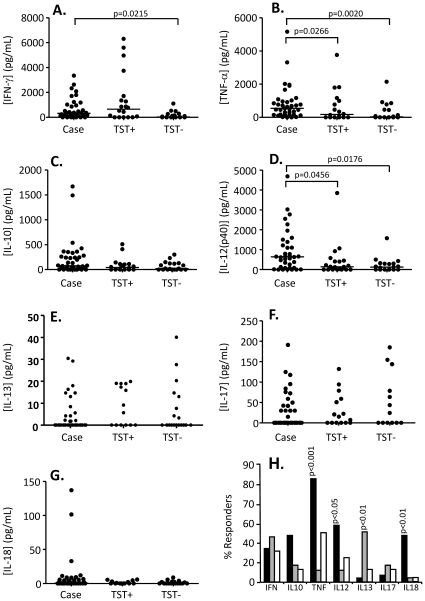
Cytokine responses following TB10.4 stimulation.Whole blood from TB cases (n = 36), TST+ (n = 20) and TST− (n = 19) contacts was stimulated for 7 days with TB10.4 and the supernatant assessed by luminex technology for secretion of cytokines. A) IFN-γ. B) TNF-α, C) IL-10, D) IL-12(p40), E) IL-13, F) IL-17 and G) IL-18. Line indicates median. Data were analysed using Tweedie distributions with p-values indicating significant differences after adjustment for age and sex. H) Percentage of responders (prior to adjustment for age and sex) producing IFN-γ, IL-10, TNF-α, IL-12, IL-13, IL-17, IL-18. Dark bars = cases, grey bars = TST+ contacts, white bars = TST− contacts; p-values are indicated and refer to comparison with TST− contacts.